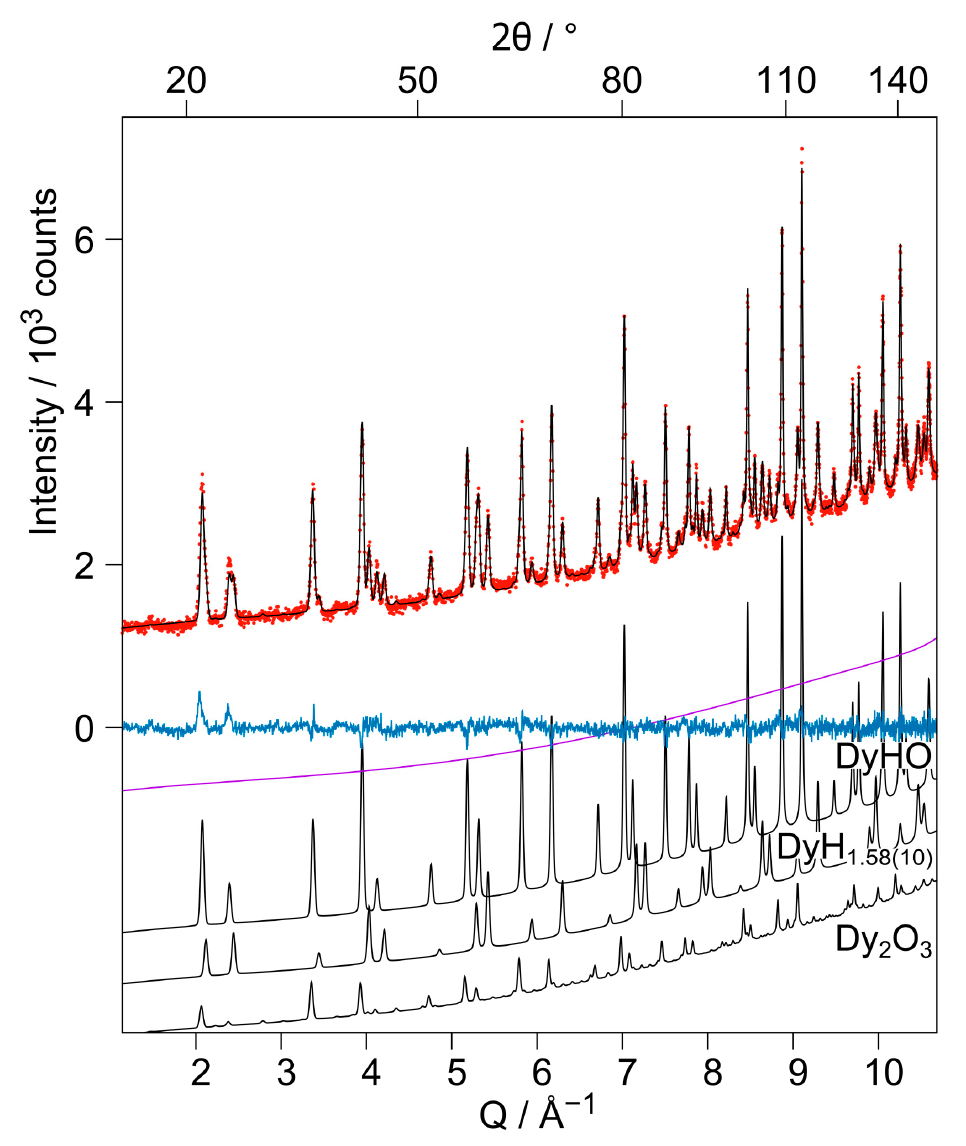
= 11.7%, a = 5.30945(10) Å), F 2